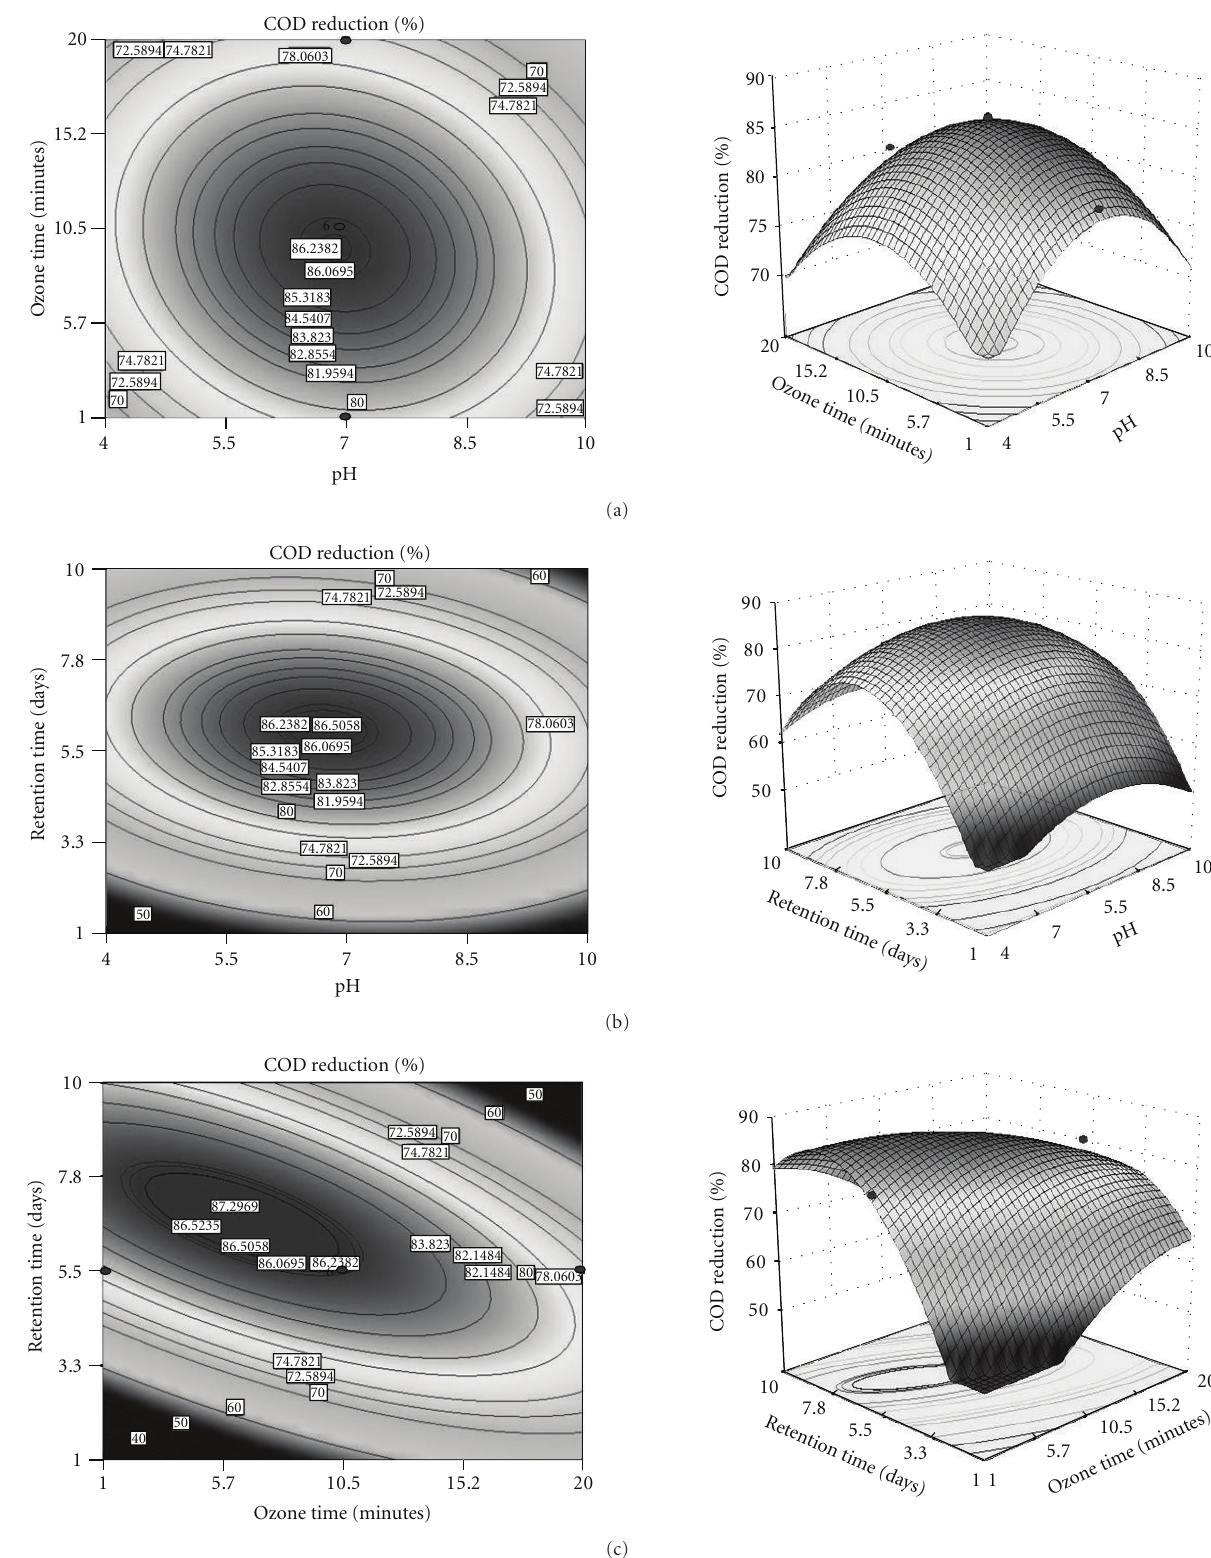
Figure 2: Contour and three-dimensional surface plot of COD reduction. (a) E ff ect of pH and ozone time at fixed retention time (5.5 days). (b) E ff ect of pH and retention time at fixed ozone time (10.5 minutes). (c) E ff ect of ozone time and retention time at fixed pH